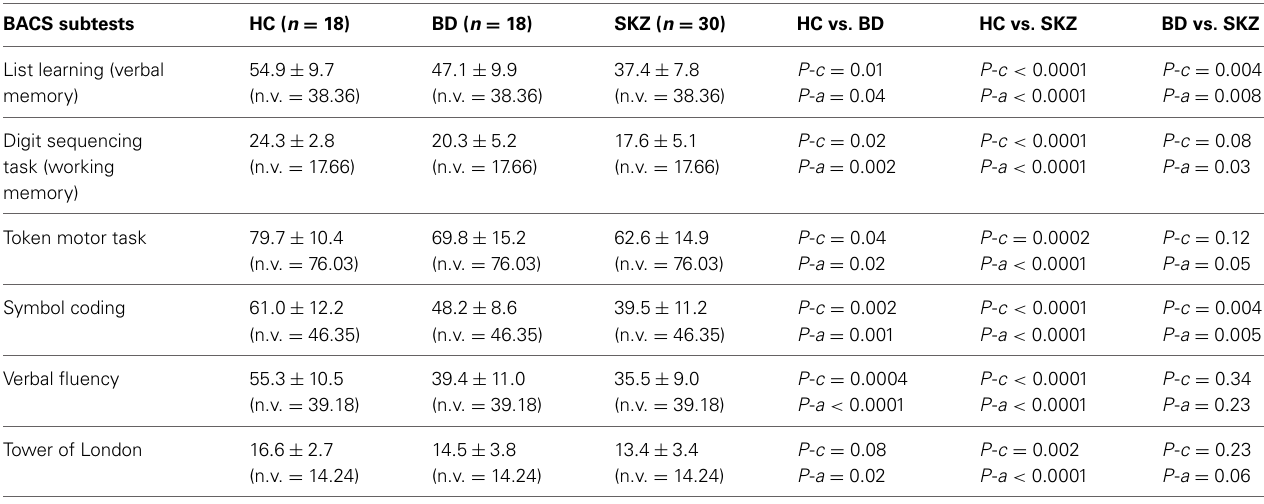
Table 2 | Performances of healthy controls (HC), bipolar disorder (BD) and schizophrenia (SKZ) patients on brief assessment of cognition in schizophrenia